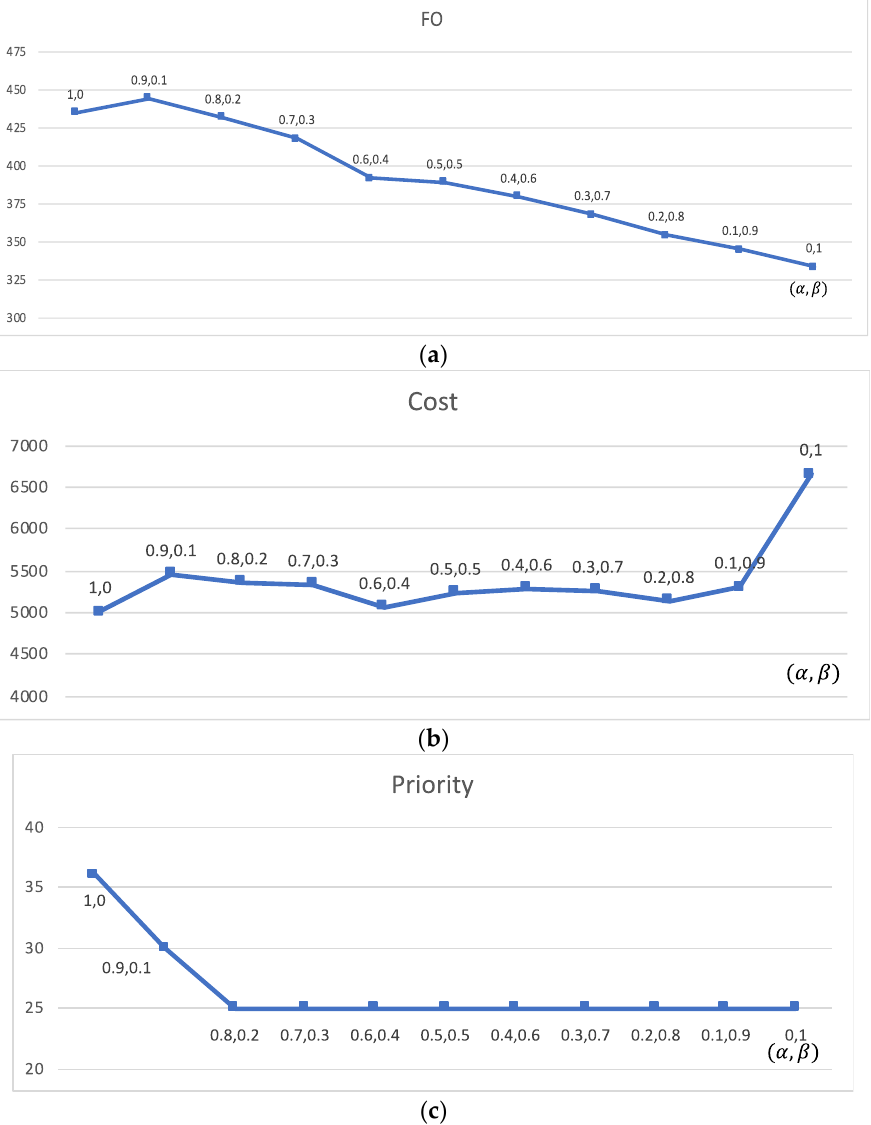
Figure 1. Effects of preference between cost ( 𝛼 ) and priority ( 𝛽 ): ( a ) objective function; ( b ) cost; ( c ) priority.